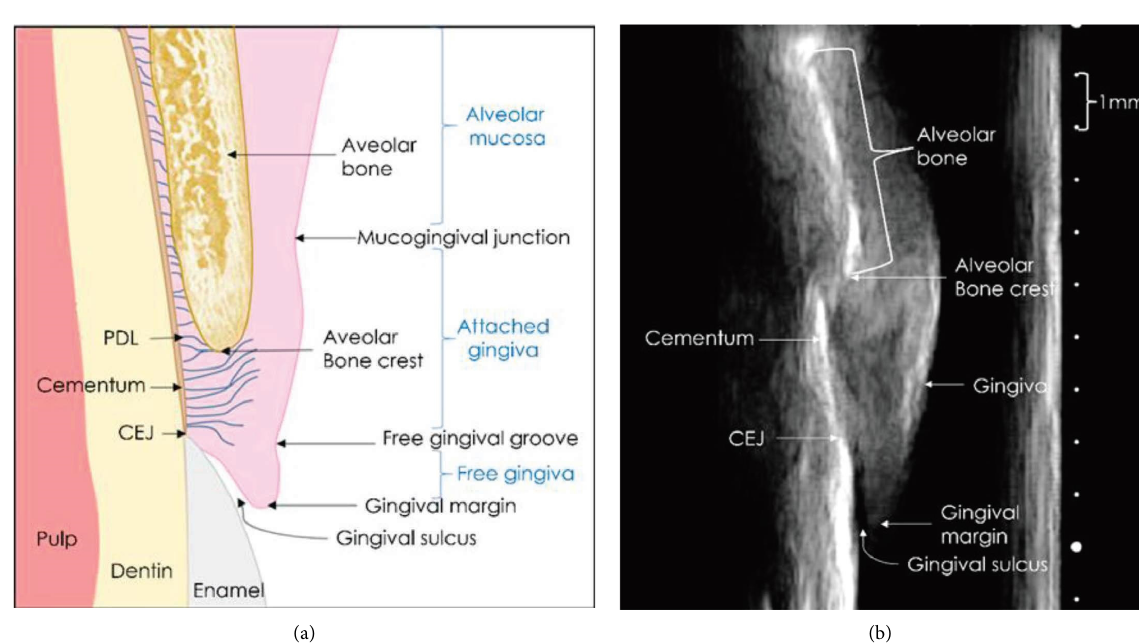
Figure 2: Te anatomy of the periodontium compared to an ultrasound image of tooth 11. Te (a) was taken from Chan et al. [37] with